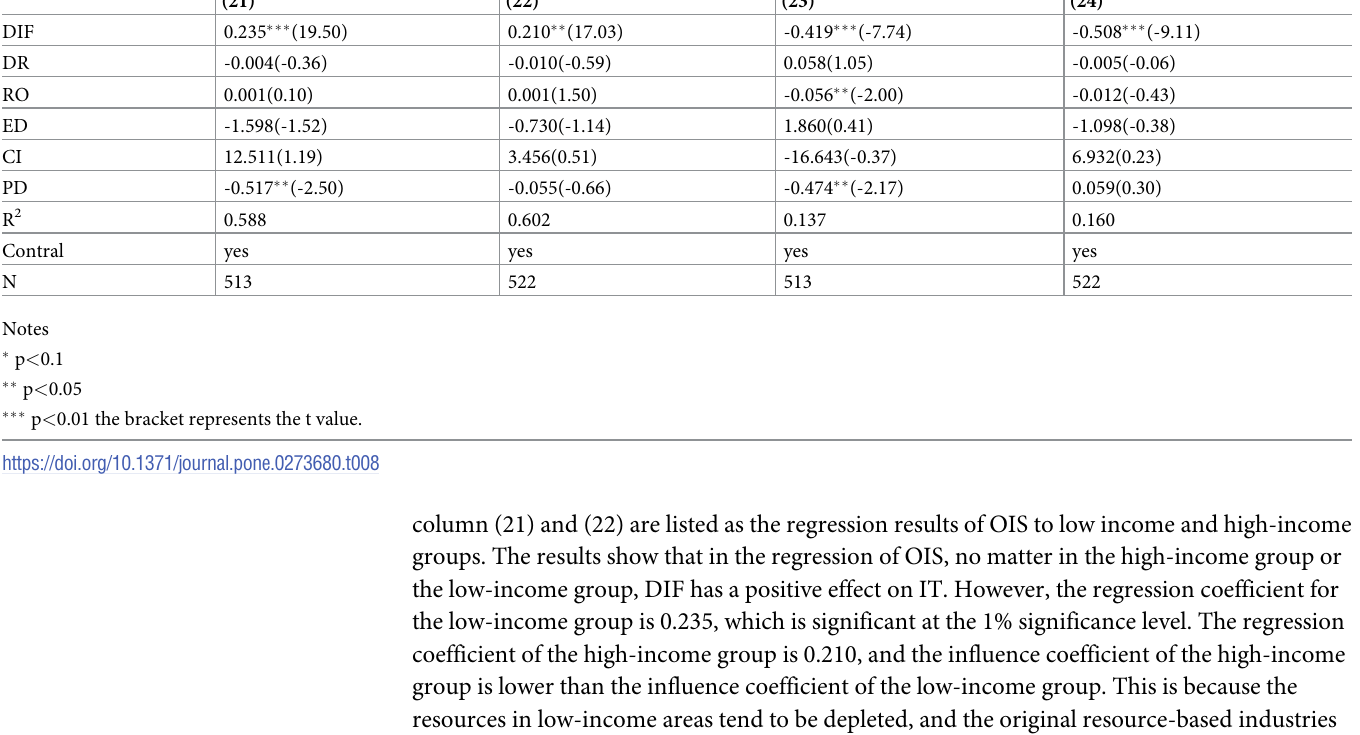
upgrading, which verifies the impact of innovation differentiation.